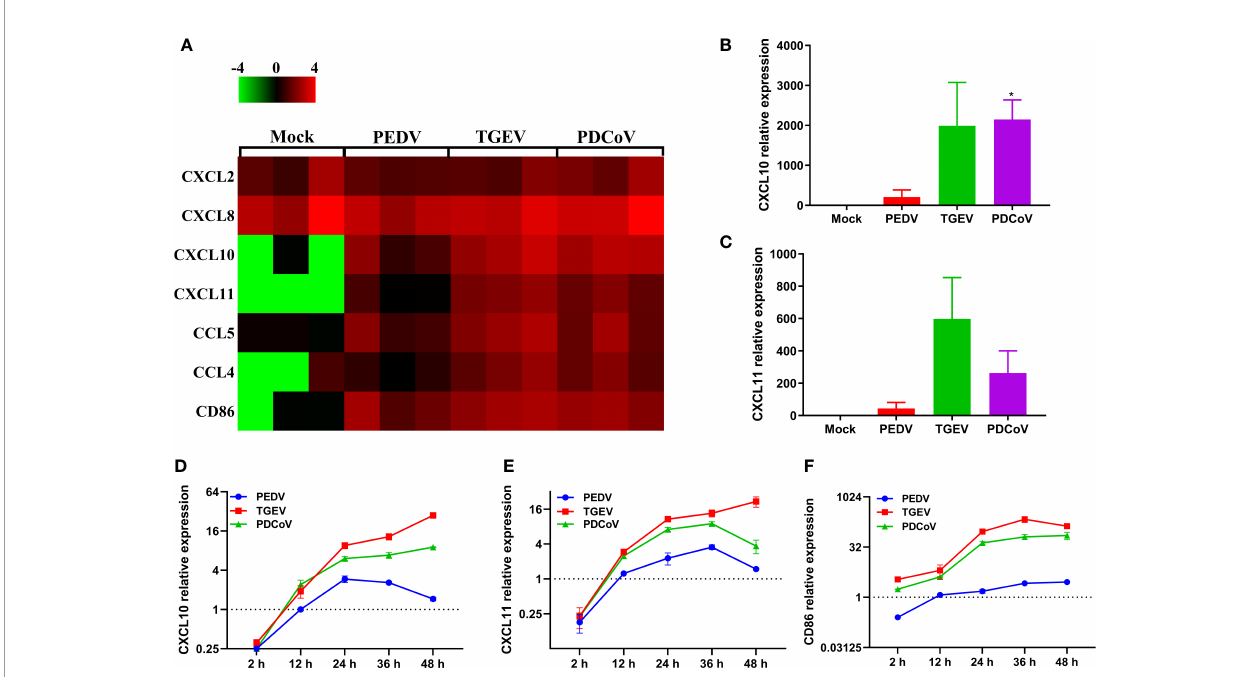
FIGURE 9 | TGEV and PDCoV, not PEDV, strongly promote the expression of chemokines related to T cell immunity in enteroids. (A) Heat map of signi fi cant induction of chemokines related with T cell immunity in enteroids infected with SECoVs. Monolayers of jejunal enteroids infected with PEDV, TGEV, and PDCoV were harvested at 24 hpi. The transcriptional expression of chemokines in enteroids was con fi rmed by RNA-Seq. Data are based on log(RPKM) values (n = 3). (B, C) Jejunal enteroids monolayers were infected with PEDV, TGEV, and PDCoV, and collected at 24 hpi to analyze the expression of CXCL10 (B) , and CXCL11 (C) by RT-qPCR. (D – F) . Following infection with PEDV, TGEV, and PDCoV, jejunal enteroid were collected at the indicated time points. The expression kinetics of CXCL10 (D) , CXCL11 (E) , and CD86 (F) were quanti fi ed by RT-qPCR. Data are presented as the means ± SEMs (n = 3). The scale data of panel D-F were taken as log 2 (fold change) values. The differences between groups were compared using the Student ’ s t test. Error bars denote the deviations, and the p values are expressed as follows: * p <